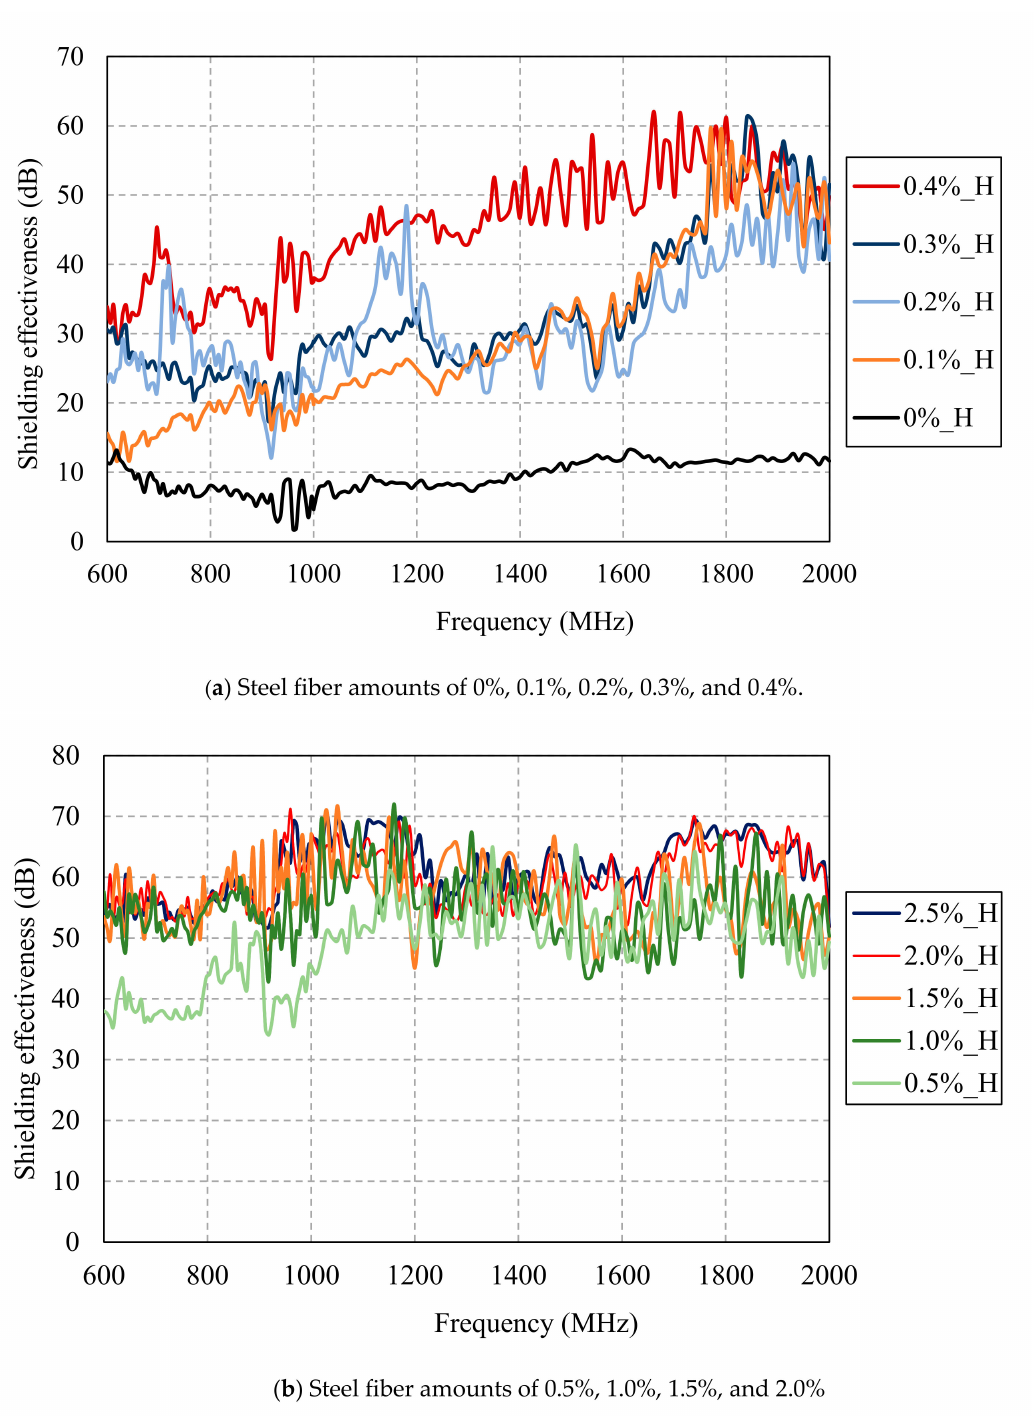
Figure 13. SE results of HPFRCC for di ff erent amounts of steel fibers measured with horizontal